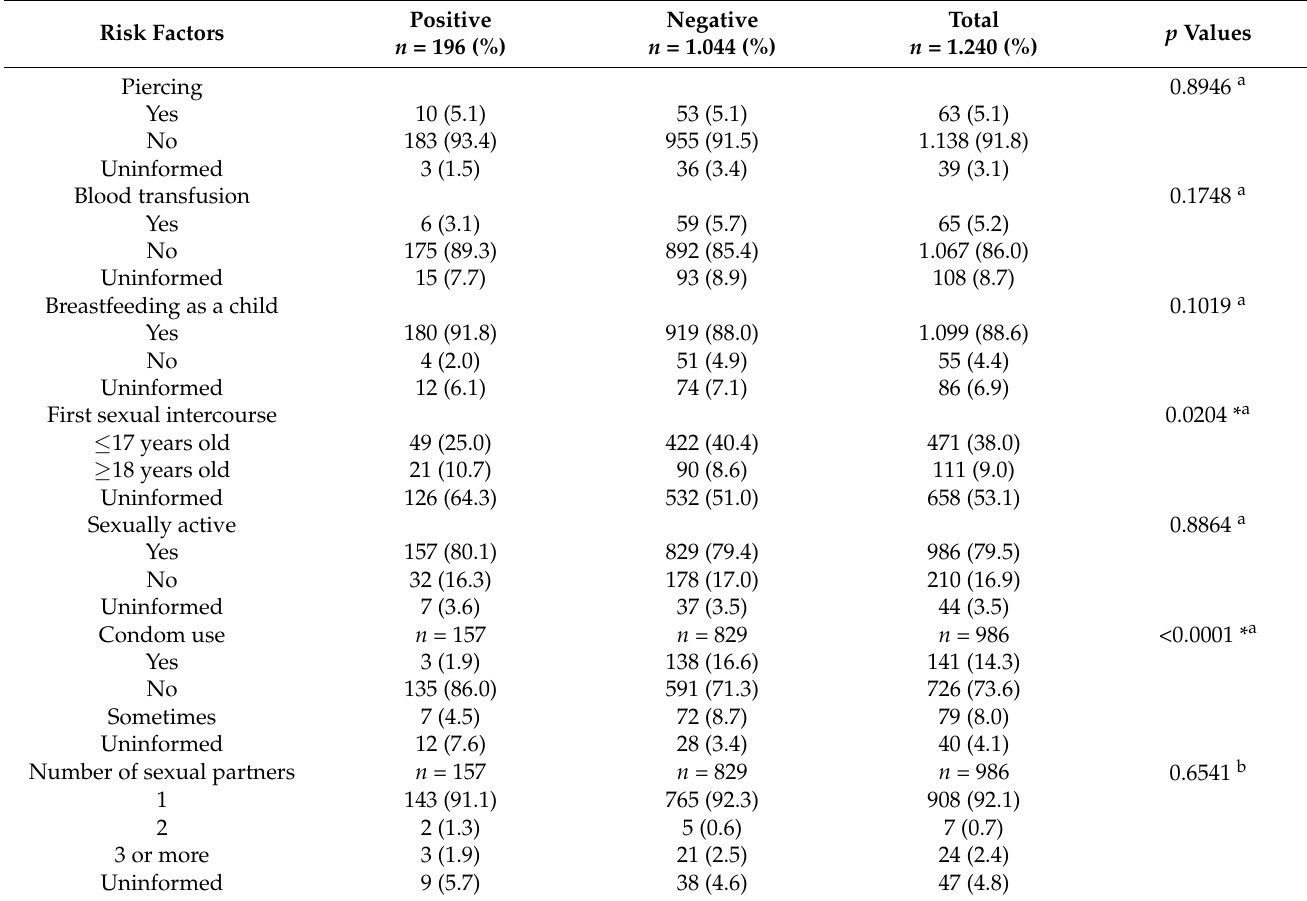
Table 3. Epidemiological characteristics of the study population.